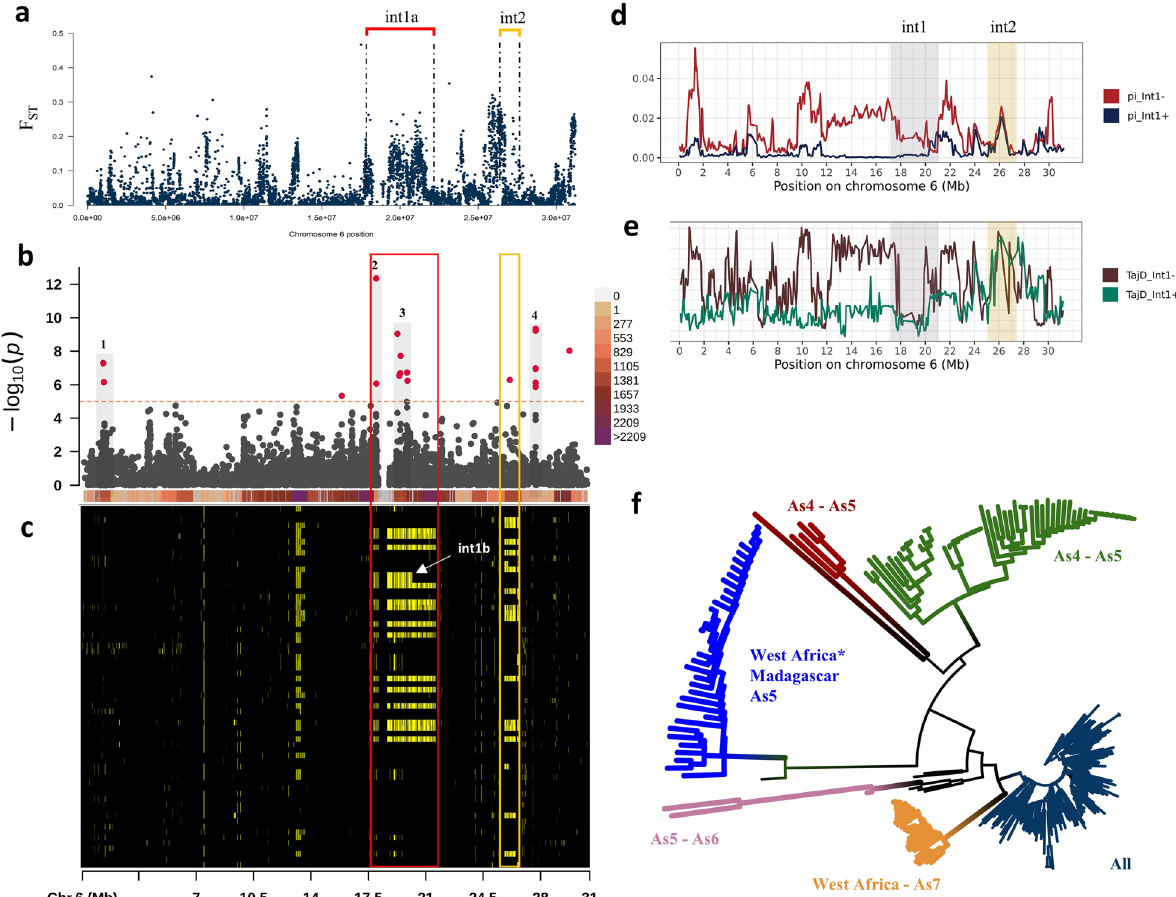
Fig. 6 Genomic differentiation and population structure: a Fixation index (Fst) on chromosome 6 between Asian versus West African tropical upland Japonica rice populations. The position of the large introgression of cAus on this chromosome is represented by the segment in red. b Manhattan plot of the iHS statistic computed on the West African tropical upland Japonica rice population. The orange line corresponds to the significant threshold. The right legend shows the density of SNPs for each 1 MB window. c Highlight of the cAus genome introgression signal in the West African tropical Japonica genetic background on chromosome 6. The color in yellow identifies the chromosome locations with haplotypes assigned to cAus. d Nucleotide diversity (Pi) on chromosome 6 between tropical accessions with (Int in blue) or without (Int- in red) the cAus + introgression. The gray band identifies the region around the introgression. e Result of Tajima’s D statistic on chromosome 6 between tropical accessions with (Int in green) or without (Int- in brown) the cAus introgression. The gray band identifies the region around the introgression. f + Unweighted neighbour tree constructed on the left outer edge of 100 Kb of the large introgression between 17.9 and 21.7 Mb on chromosome 6. West Africa annotated with an asterisk (*) denotes Tropical Japonica with cAus